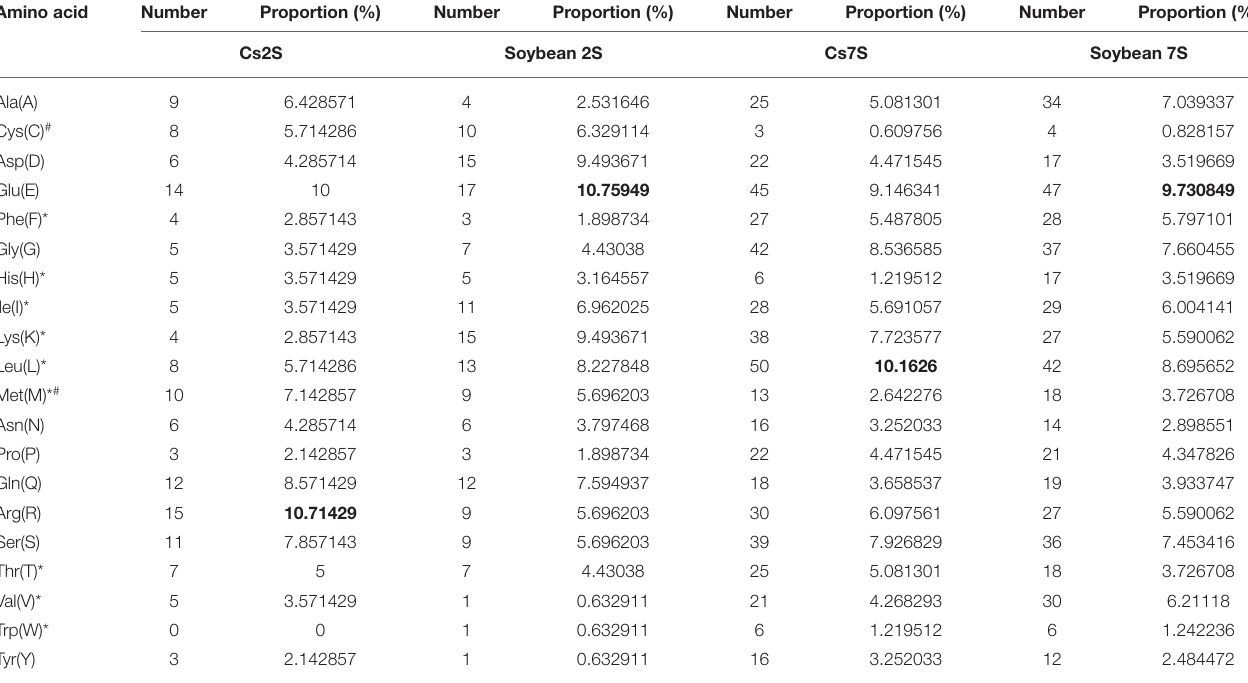
TABLE 2 | Amino acid composition of 2S albumin and 7S vicilin protein. Amino acid